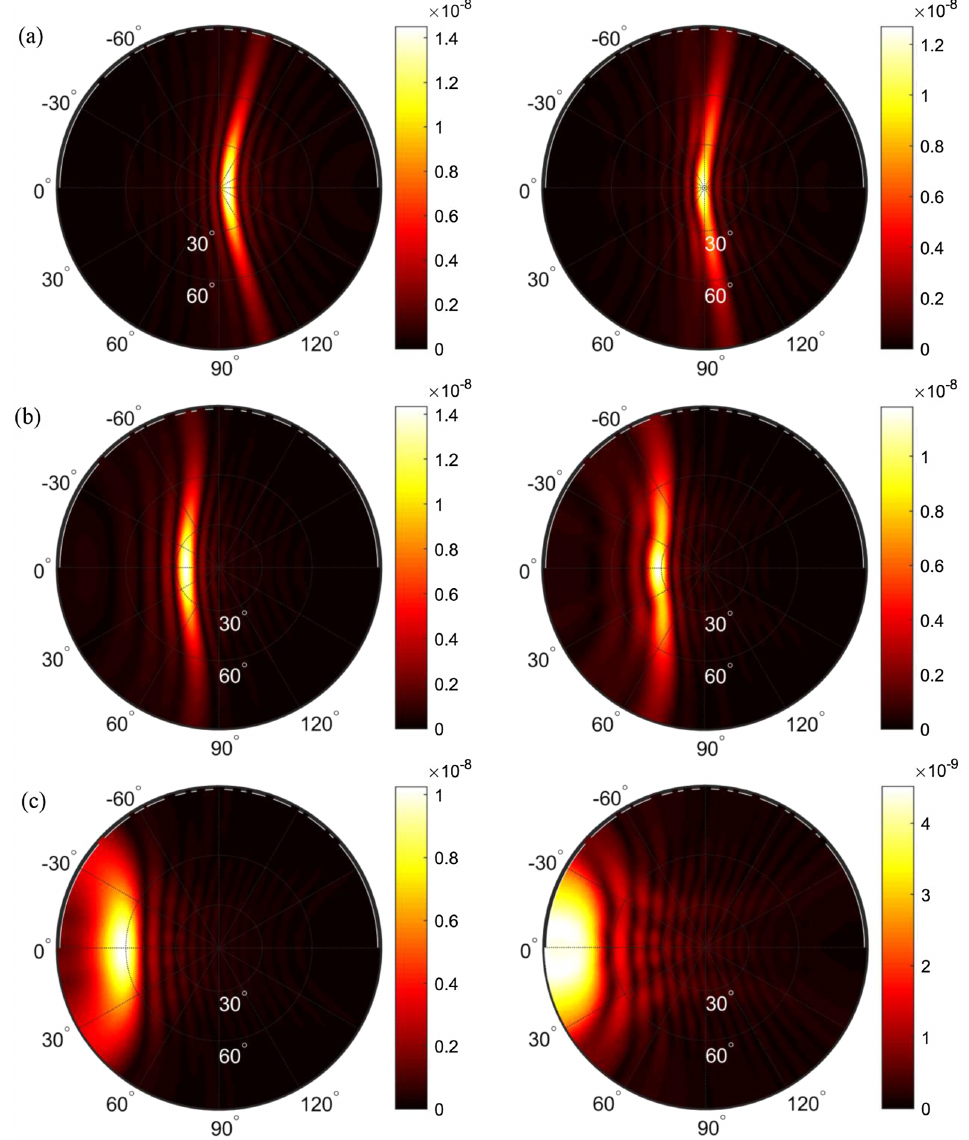
⃗ E FIG. 3. Electric field magnitude j jð V · s = m Þ in the far-field zone at R ¼ 1000 k − 1 . Spherical coordinate system (8) is used, the radial axis represents the Θ angle, and the polar axis is the Φ angle. Problem parameters: q ¼ 1 nC, ε ¼ 4 , μ ¼ 1 , d ¼ b ¼ 50 k − 1 , ak ¼ 1